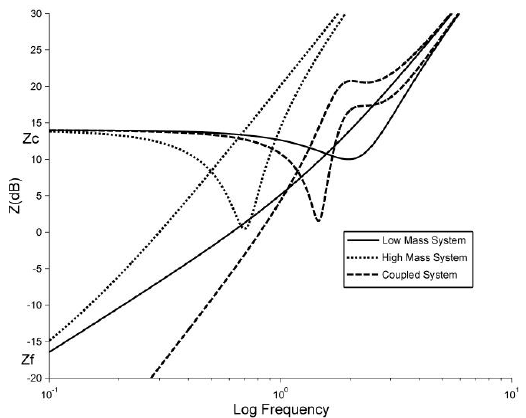
Figure 1. Comparison of impedance response of the low mass ( m 1 = 1 kg), high mass ( m 1 = 10 kg) and coupled systems ( m 1 = 1 kg, m 2 = 15 kg). For all systems b 1 = 1.5 N/ms −1 and k 1 = 0.0 N/m in open loop and 5.0 N/m in closed loop. For the coupled system systems b 2 = 10 N/ms −1 and k 2 = 50.0 N/m (Axis values have not been added as the graphs in this section are intended to demonstrate specific features of interest as opposed to relating to a real world